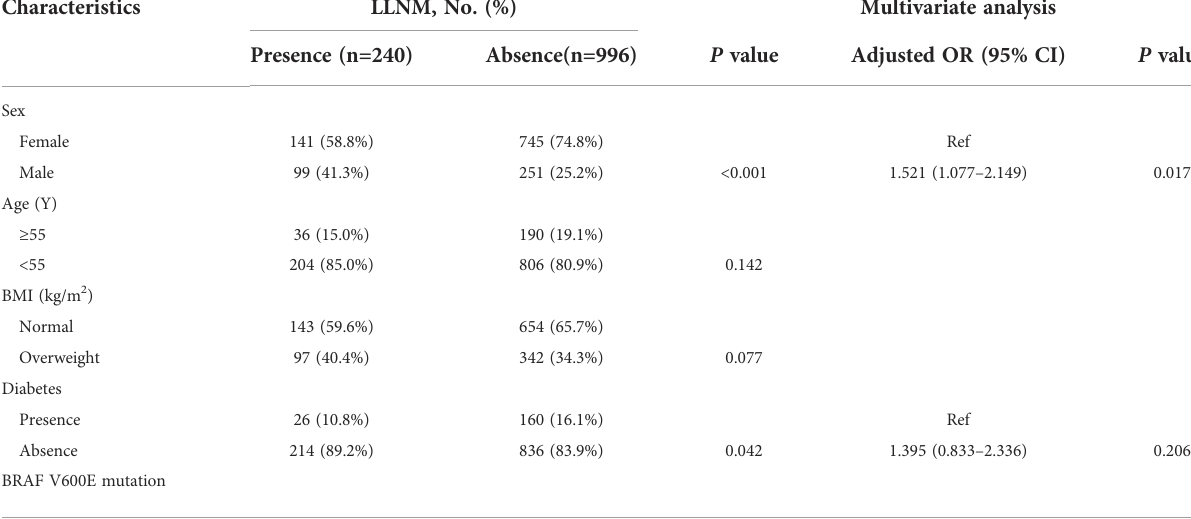
TABLE 2 Univariate analysis and multivariate analysis of factors associated with LLNM in whole cohort.